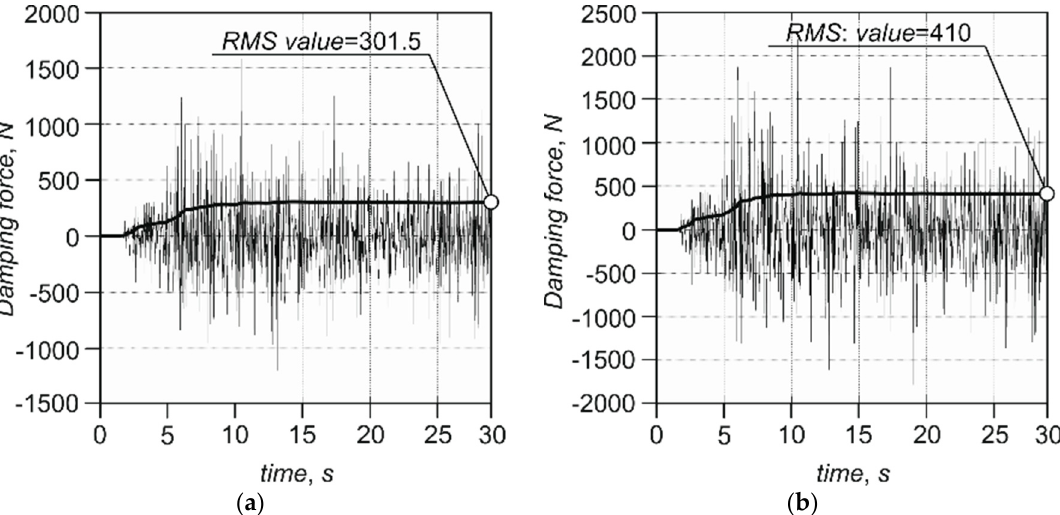
Figure 9. Damping force dependencies, over time, for road no. 6: ( a ) with permanent damping ( h SF 1 = 7500 Ns/m); ( b ) with the optimized damping law. Energies 2017 , 10 , 1742